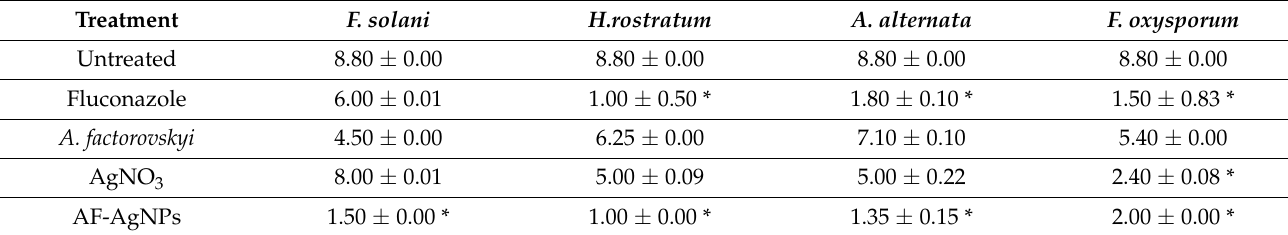
Table 5. The antifungal activities of A. factorovskyi ethanolic extract and AF-AgNPs by measuring the average mycelium growth